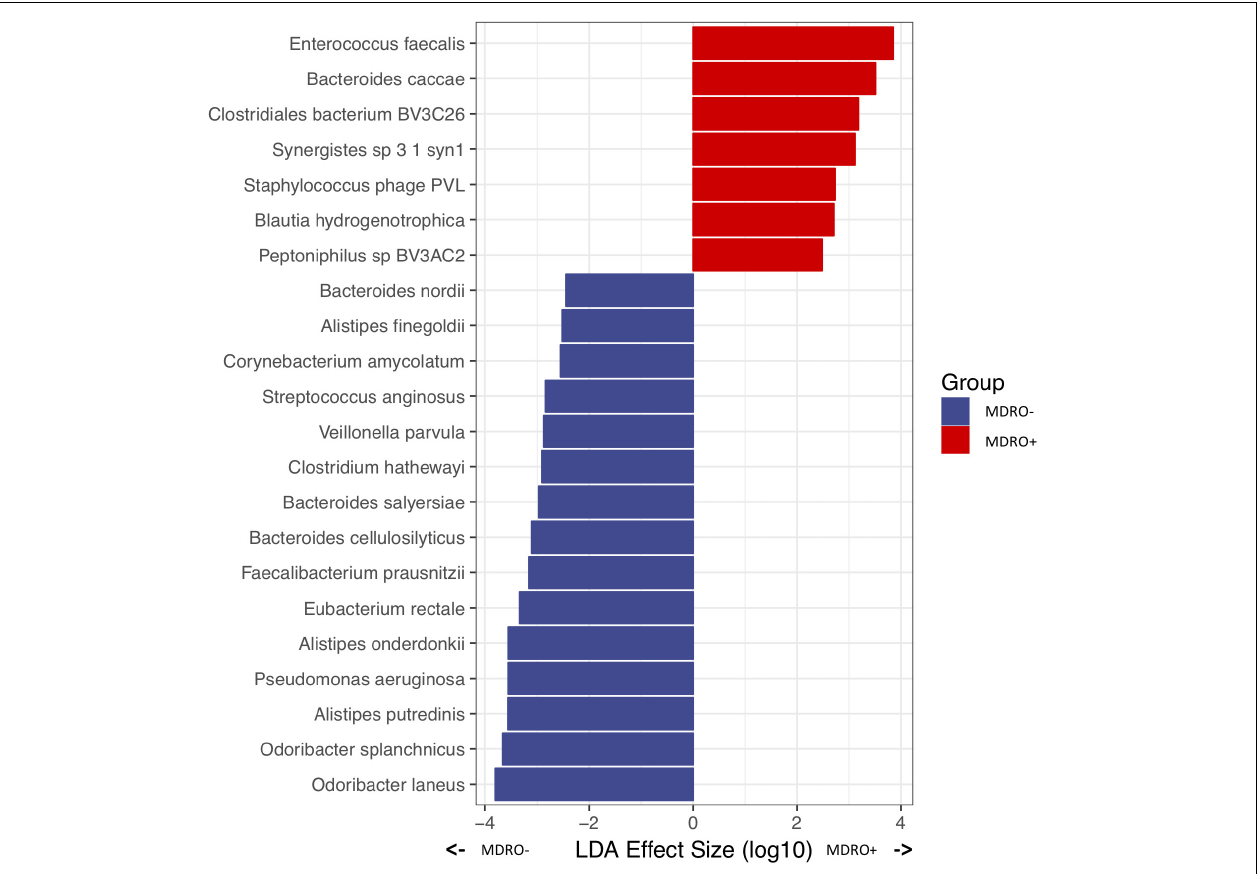
FIGURE 7 | Differentially abundant microbial species in a priori samples from subjects who were MDRO- or MDRO+, as determined by whole metagenome shotgun (WMS) sequencing. MDRO, multidrug-resistant